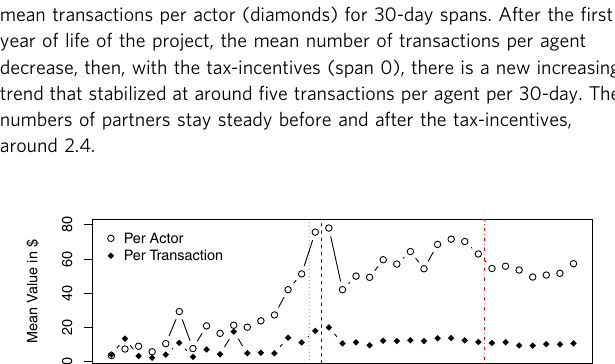
Figure 4 (circles) also shows the mean number of partners with which an agent is doing transactions. The number of partners is small, on average around 2.4 before and after the laws. Agents do